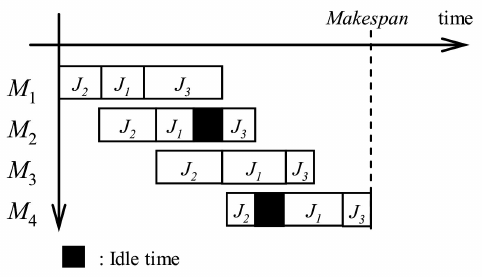
Figure 1. Flowshop problem with three jobs and four